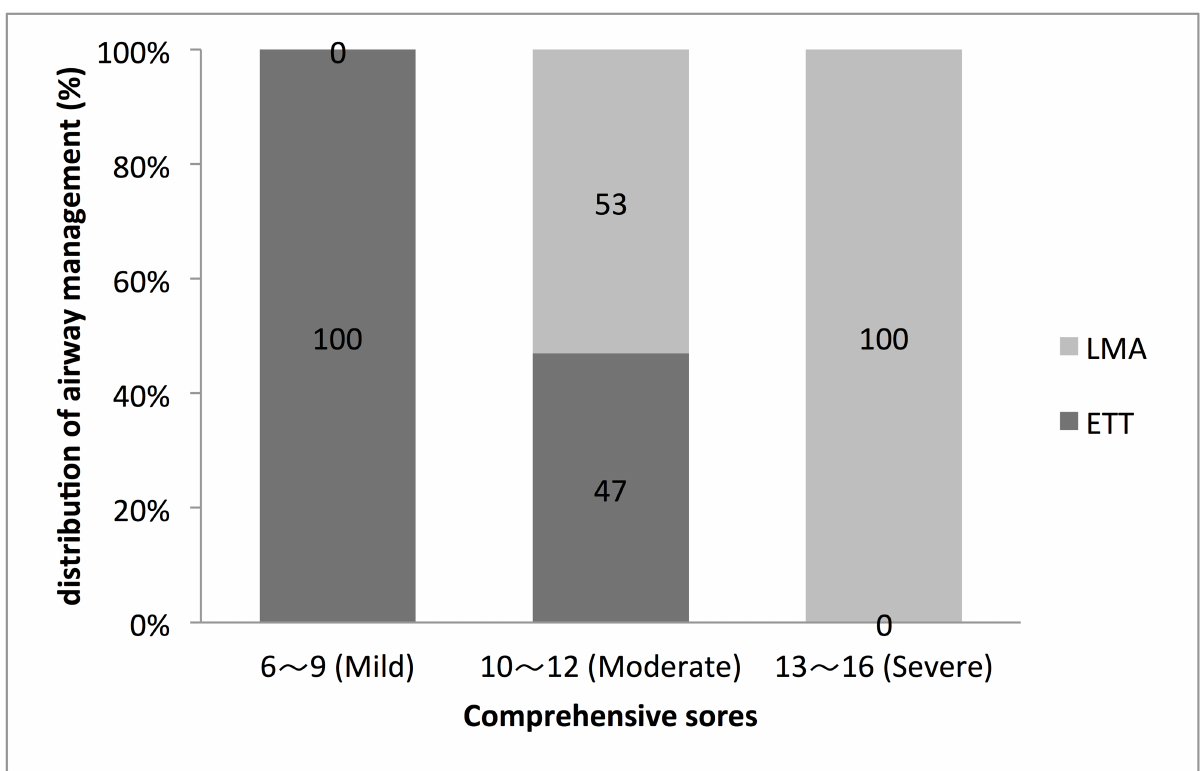
Fig 1. The relationship between comprehensive scores and airway management. (LMA: LaryngealMask, ETT: Endotracheal Intubation).